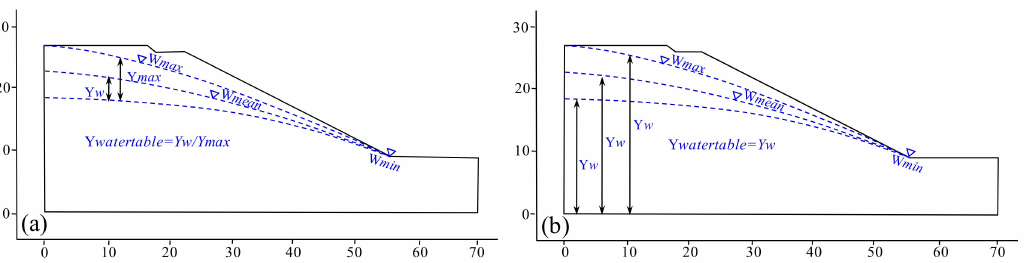
Figure 17. ( a ) The normalized water table level employed in Shadabfar et al., (2020) [59]; ( b ) the water table level used in this paper.